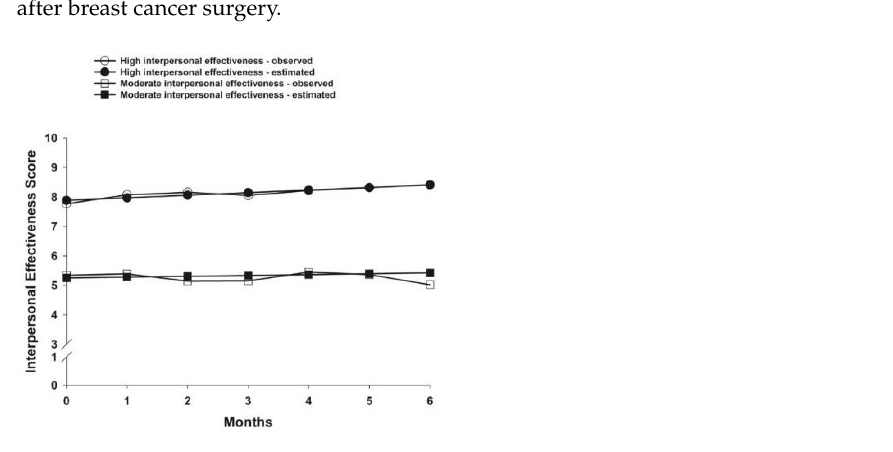
Figure 4. Observed and estimated interpersonal effectiveness latent classes from prior to through to 6 months after breast cancer